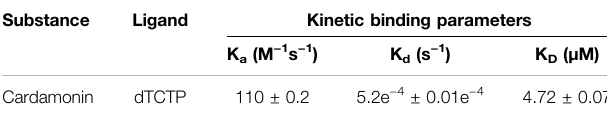
TABLE 1 | Kinetic binding parameters for cardamonin. Cardamonin binding to dTCTP determined by SPR (Reichert SPR SR7500 instrument). Substance Ligand Kinetic binding